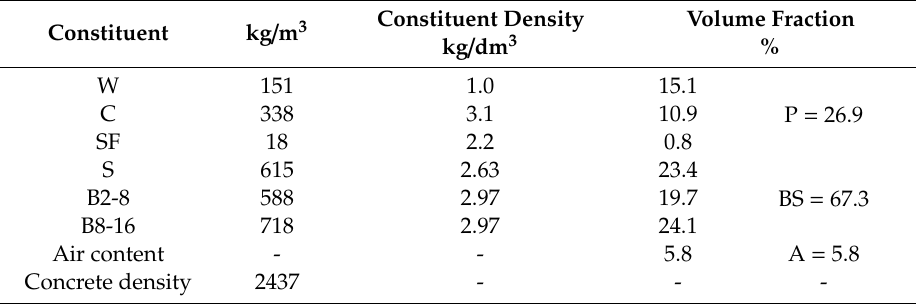
Table 2. Concrete composition data.